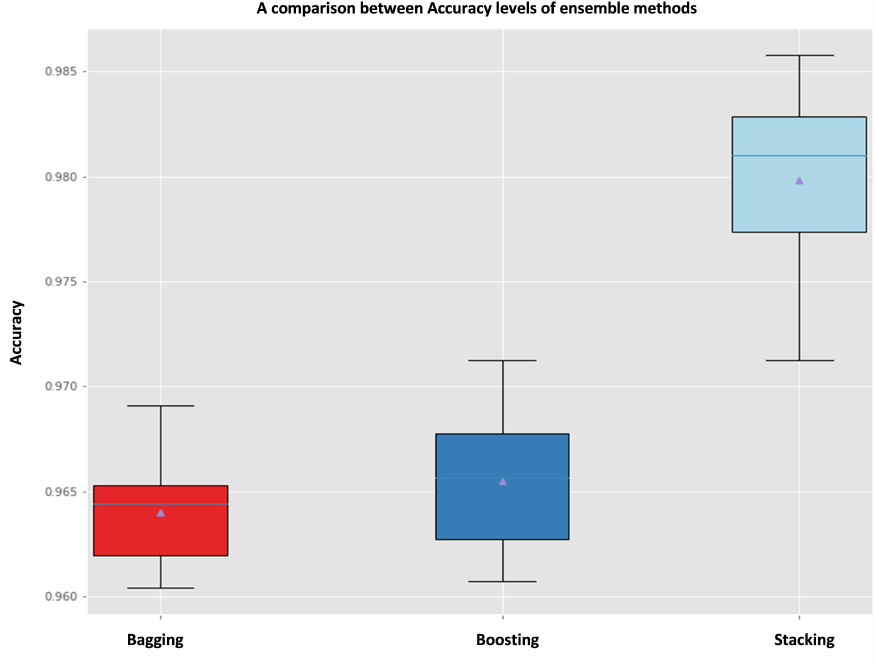
Figure 14. Accuracy levels comparison of Bagging, Boosting and Stacking Ensemble